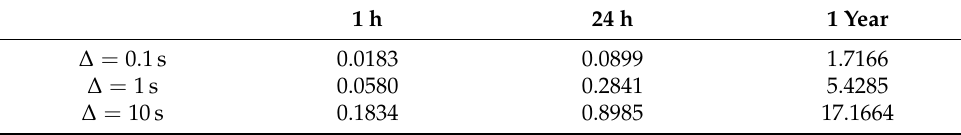
Table 3. S.D. of SOC error (%) for smart phone data. 1 h 24 h 1 Year ∆ = 0.1s 0.0588 0.2879 5.5002 ∆ = 1s 0.1858 0.9104 17.3930 ∆ = 10s 0.5877 Table 4. S.D. of SOC error (%) for EV data. 1 h 24 h 1 Year ∆ = 0.1s 0.0183